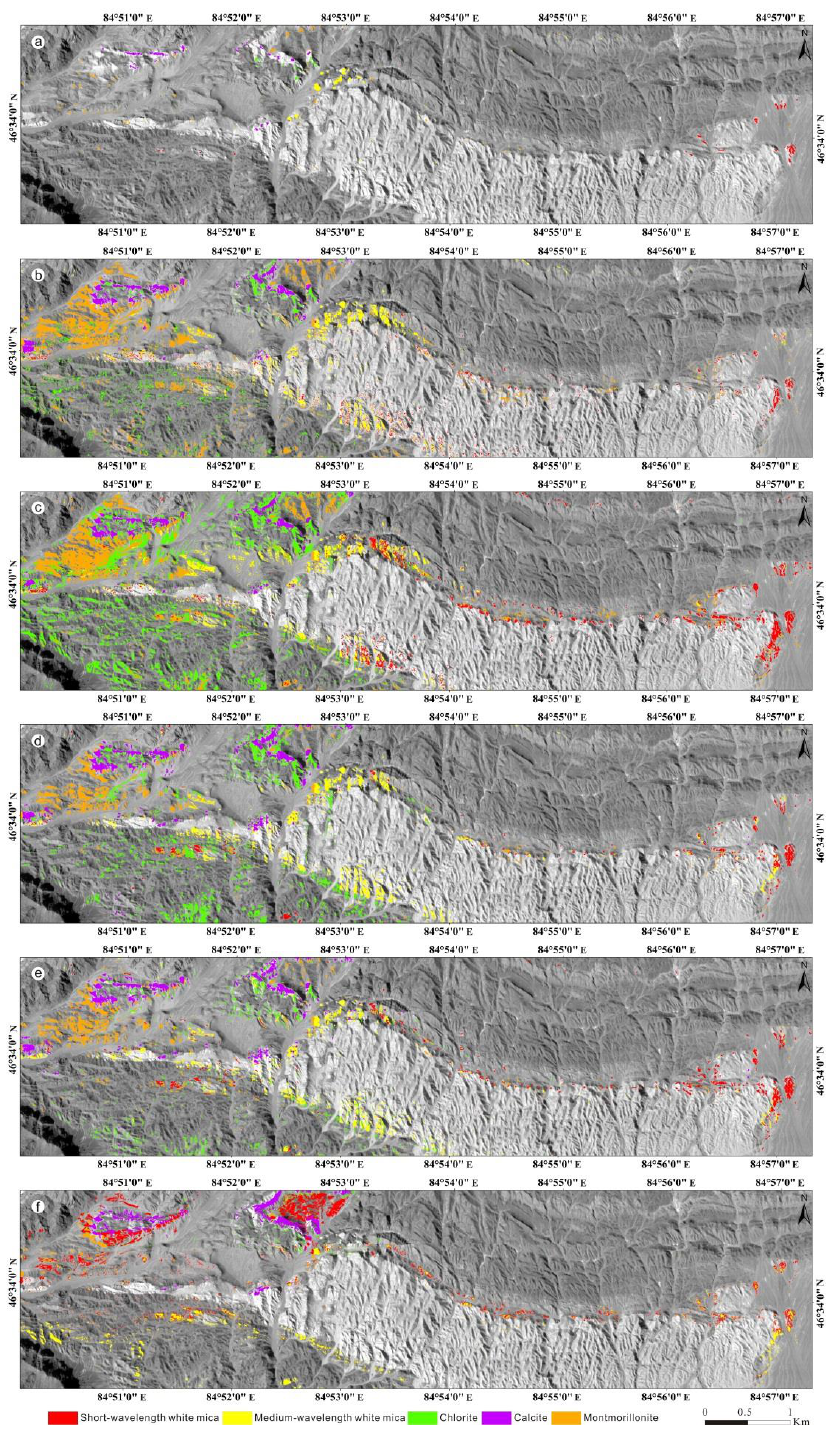
Figure 12. ( a ) Sample distribution map of the test area. ( b ) Mineral mapping results of the SASI hyperspectral data based on the SVM method. ( c ) Mineral mapping results of the SASI hyperspectral data based on the FCNN model. ( d ) Mineral mapping results of the SASI hyperspectral data based on the 1D CNN model. ( e ) Mineral mapping results of the SASI hyperspectral data based on the 1D and 2D CNN model. ( f ) Mineral mapping results of the SASI hyperspectral data based on the MTMF